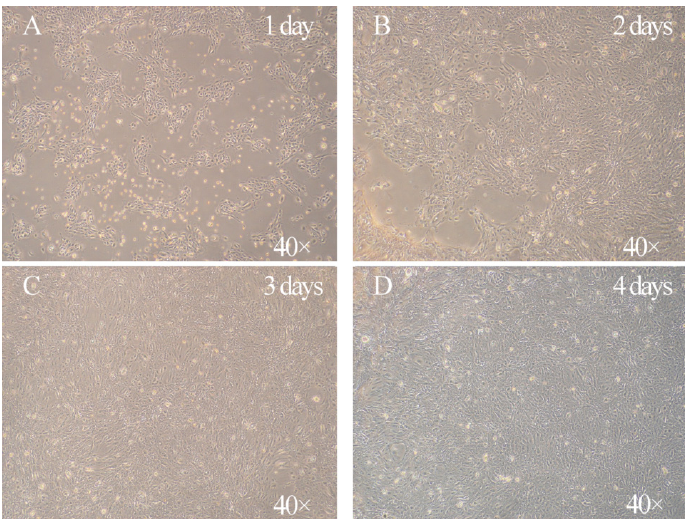
Figure 1. The morphology of cultured GRECs. ( A ) 1 day of culture. ( B ) 2 day of culture. ( C ) 3 day of culture. ( D ) 4 day of culture. Magnification 40×.